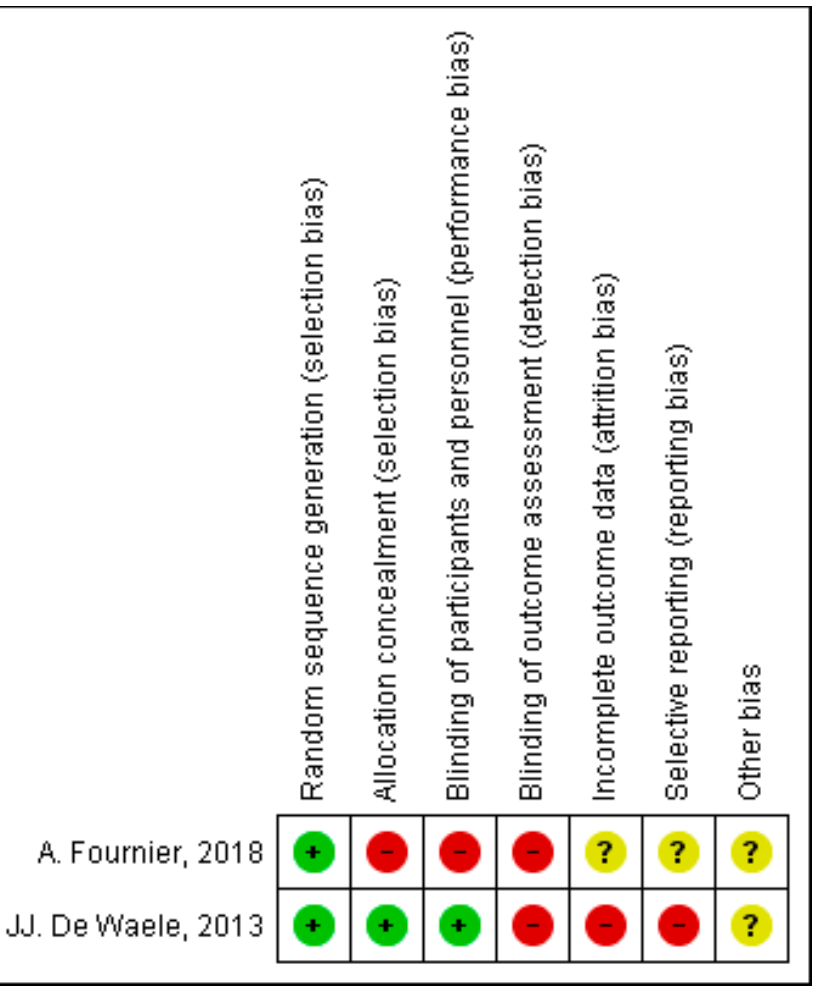
Figure 3. Risk of bias in randomized controlled trials using Cochrane risk of bias tool.